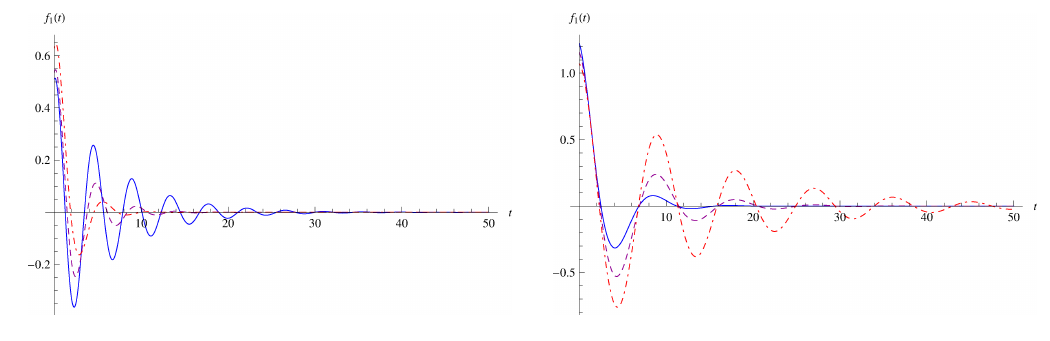
Fig. 3. The curves of f 1 .t/ for b D c D 1 and for ˛ D 1:25 (solid line), ˛ D 1:5 (dash line) and ˛ D 1:75 (dot-dash